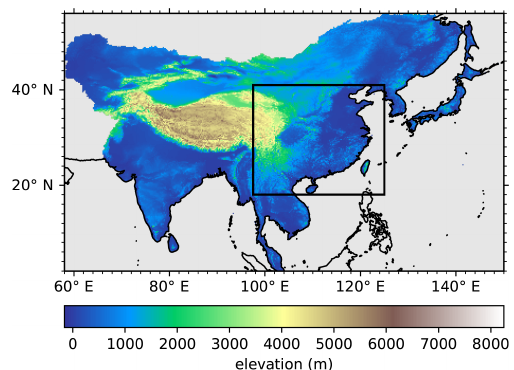
Figure 2. Asia, as represented by the HydroBASINS level-1 dataset (coloured), showing the terrain elevation. The black rectangle is the region of interest over south-eastern China shown in Figs. 9 and 10. Prominent features which are discussed are the Tibetan Plateau, par- ticularly the Himalayas on its southern flank. Also, the diurnal cy- cle over the Sichuan Basin (centred on 30 ◦ N, 106 ◦ E) will be dis- cussed. The 30arcsec elevation data from the HydroSHEDS dataset (Sect. 2.4.1) are